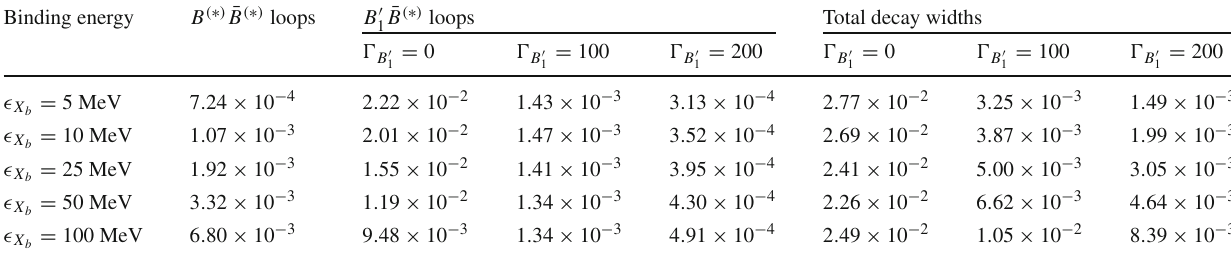
to be 0, 100, and 1